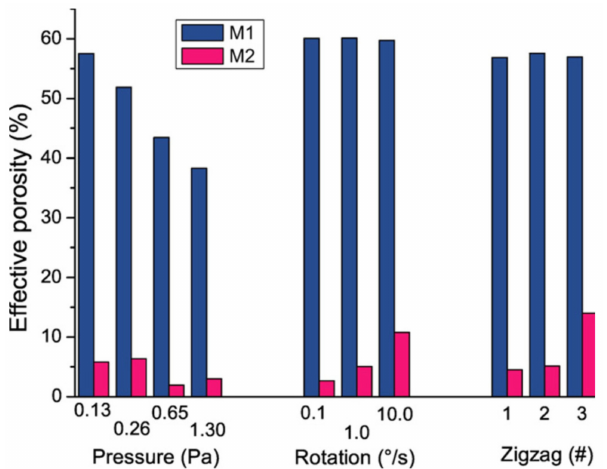
Figure 12. Kinetic Monte Carlo (kMC) tri-dimensional (3D) analyses of the effective porosity for different conditions with pore sizes above 0.64 nm (M1) and above 3.2 nm (M2) (reproduced from [50] with permission from Elsevier, 2017).